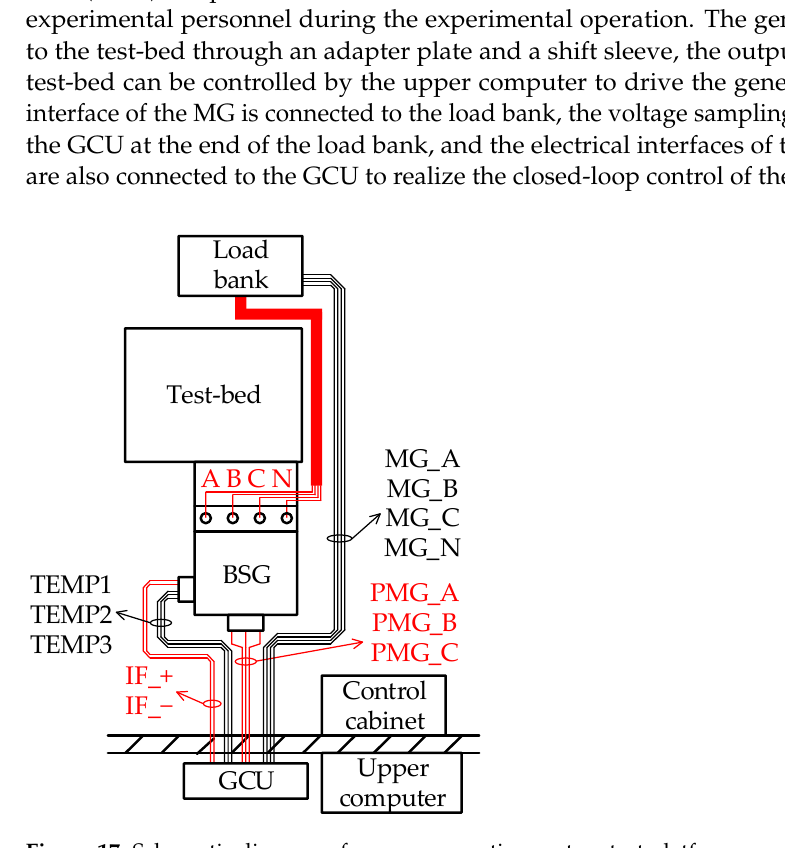
Figure 17. Schematic diagram of power generation system test platform.